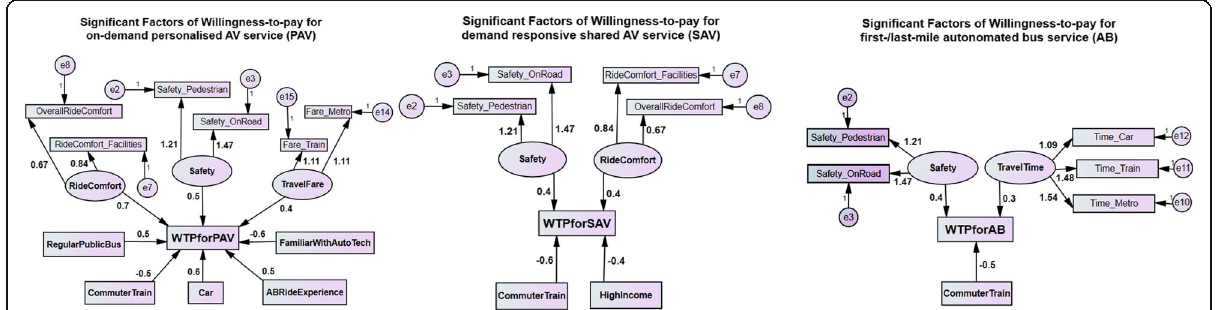
Fig. 5 Significant factors influencing WTP for three AV services: PAV, SAV and AB (with p -value less than